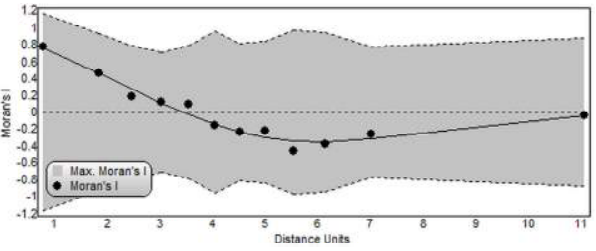
Figure 2. Moran’s I for the proportion of agricultural land un- der organic farming (logarithmically transformed) in French departments